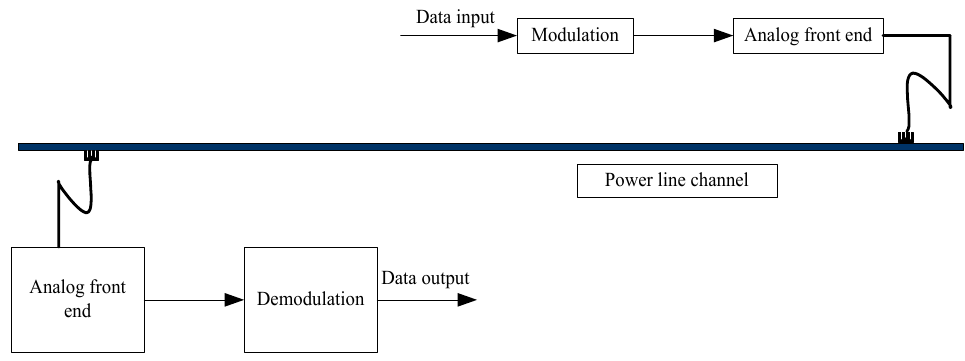
Figure 4. Signal modulation and demodulation process.